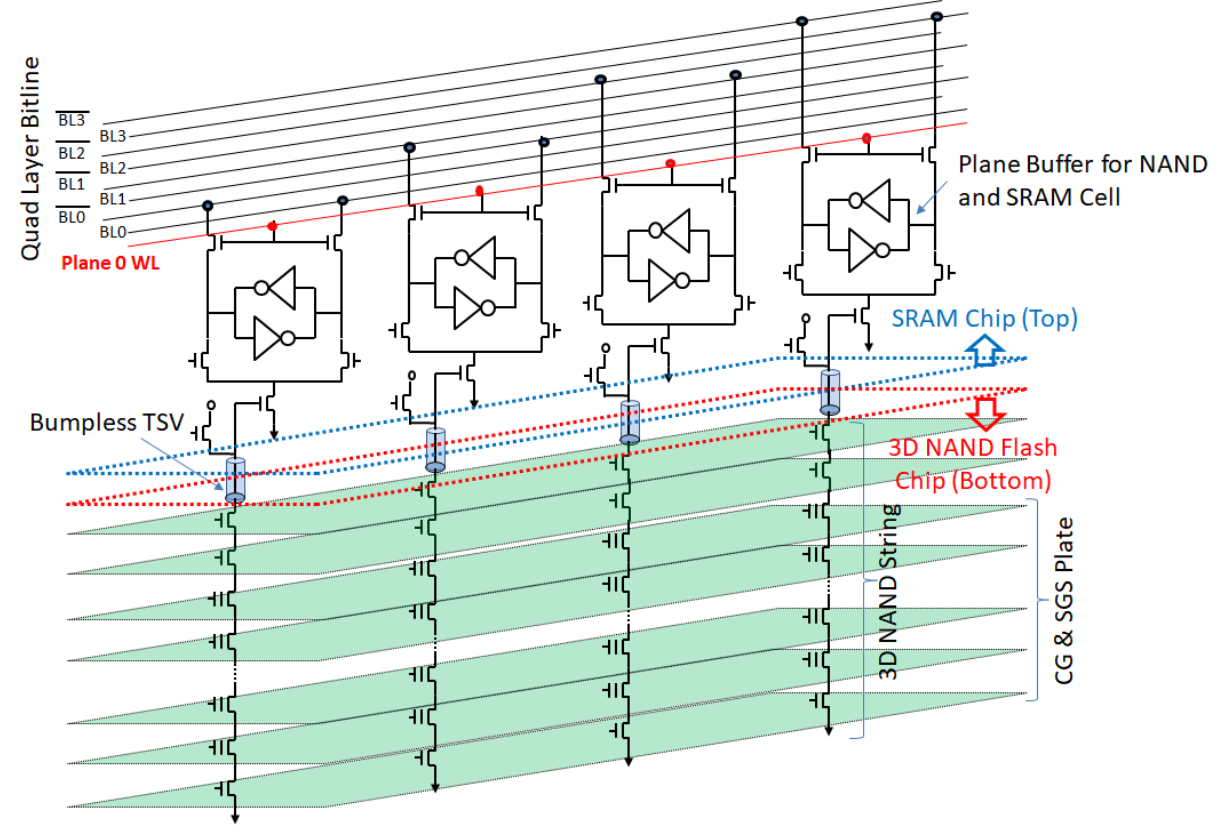
Figure 44. Circuit diagram of BBCube NAND composed of two chips.